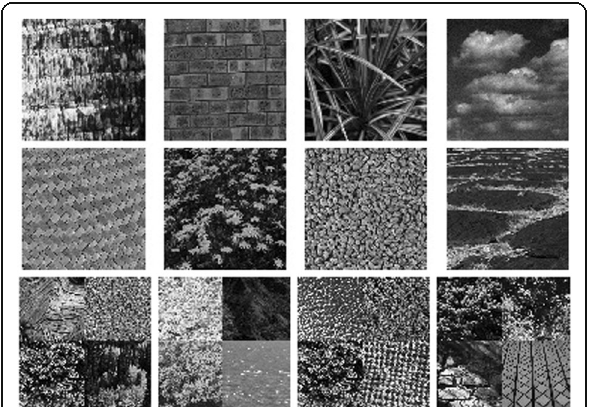
Fig. 6 Texture samples from Vistex album